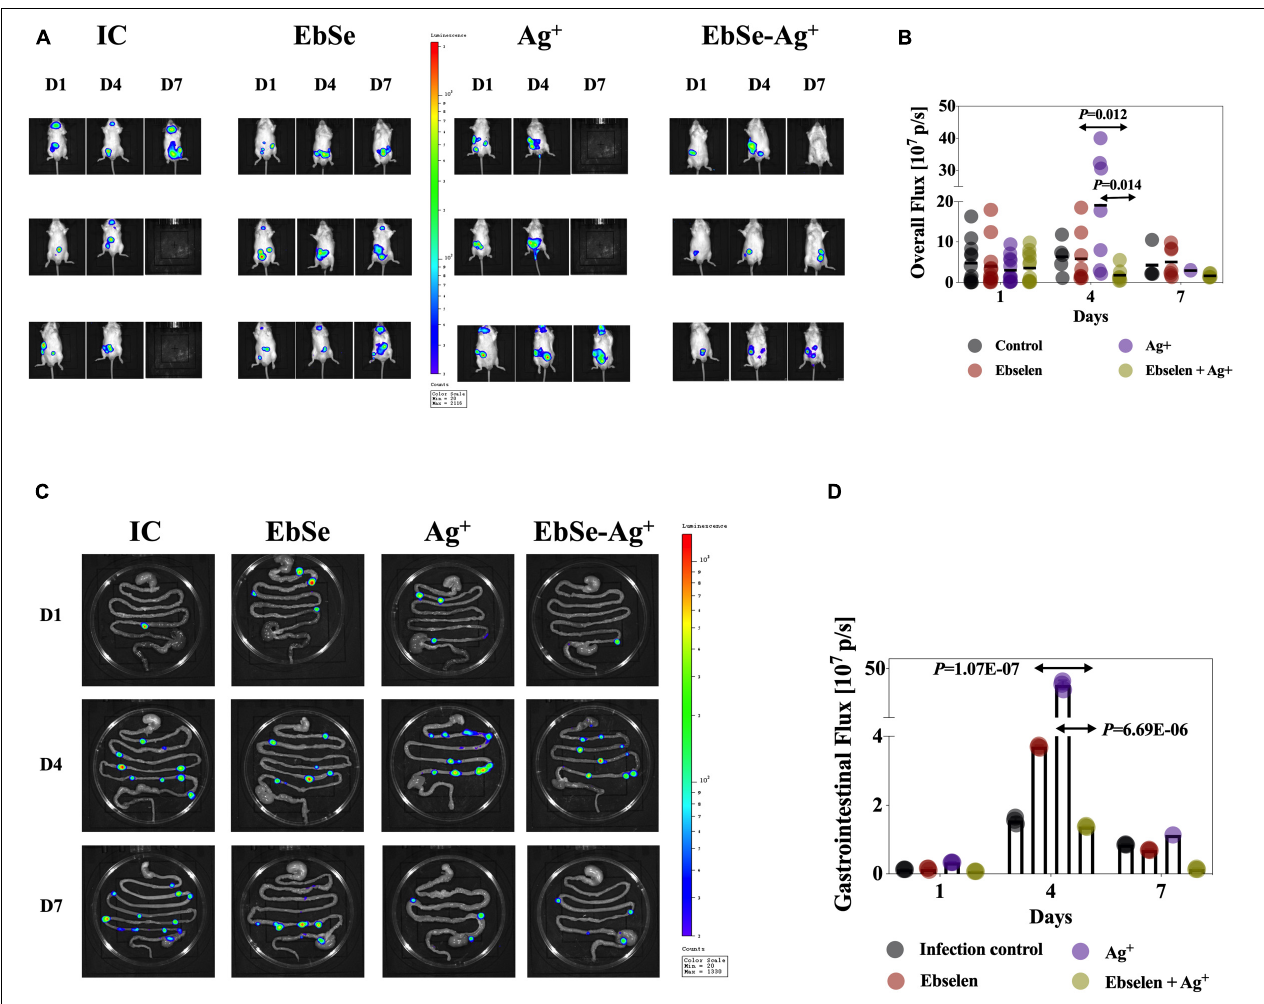
FIGURE 9 | EbSe-Ag + protects mice from YpIII-caused pseudotuberculosis. YpIII-illuminous were orally administrated into mice, and further treated with EbSe-Ag + . (A,B) Mice were monitored for bioluminescent emission using IVIS lumina II (Caliper LifeSciences) at 1-, 4-, and 7-days post-infection. (C,D) Mice were euthanized, the gastrointestinal tracts were removed, and imaged by bioluminescent imaging to analyze bacterial localization within gastrointestinal tracts at 1-, 4-, and 7-days post-infection. IC: infection (illuminous) control.